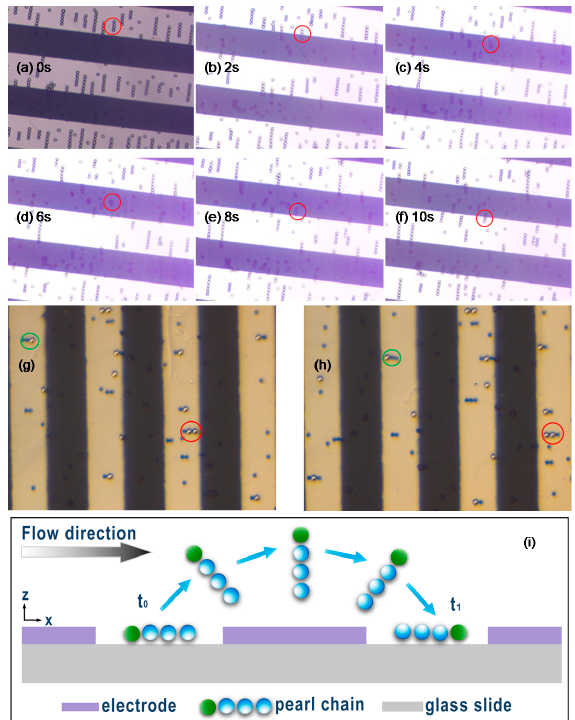
Figure 1. Optical images showing the tumbling motion of particle chains. A chain of four particles circled in red moves with the flow in a gap region ( a ) near the edge of an electrode ( b ), above the electrode off to the upper side ( c ), at the center the electrode ( d ), off the lower side ( e ), and near the other edge of the electrode ( f